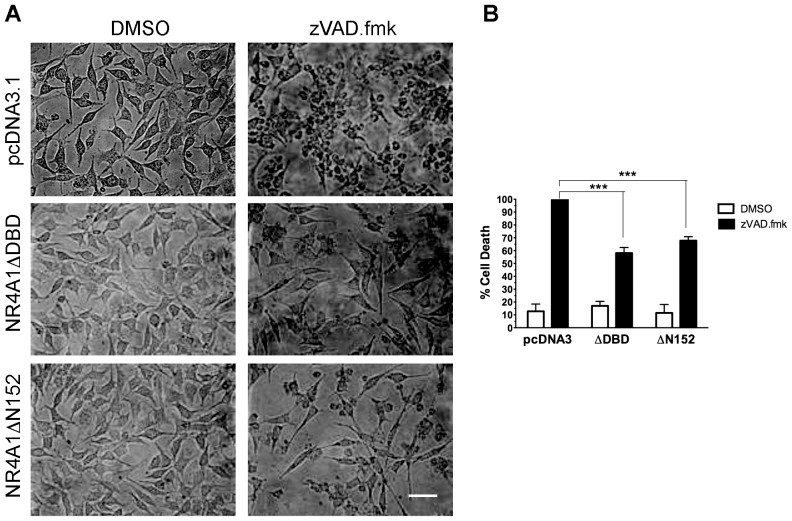
Expression of NR4A1 dominant negative mutants inhibits autophagic cell death induced by caspase inhibition.Mouse fibroblasts L929 were transfected with the indicated expression vectors, and treated or not with the pan-caspase inhibitor zVAD.fmk to induce autophagic cell death. A, cells exposed to zVAD.fmk were rounded up unless they expressed the indicated mutants. Scale bar, 50 µm. B, cell death determined by trypan blue exclusion 24 hr after treatment. There is a reduction of cell death by the expression of either NR4A1 dominant negative mutant ΔDBD or ΔN152, even though the efficiency of transfection was on average 30%. (n = 3; ***, p<0.001).